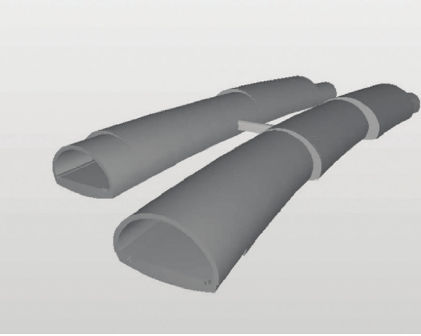
Figure 5: Tunnel model.